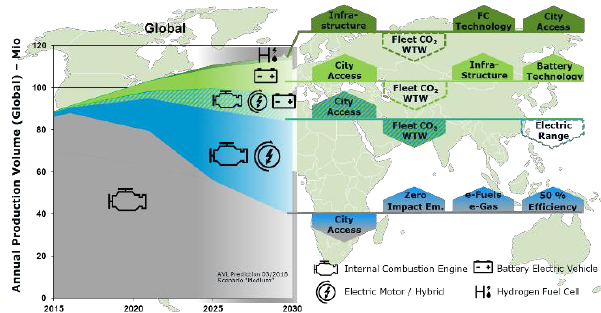
Fig. 2. Main factors influencing the long-term global technology distribu- tion [1] In addition to the reduction of pollutant emissions, ful- filling the fleet CO limits is a key driver for electric vehi- 2 cles, whose emission contribution is currently rated